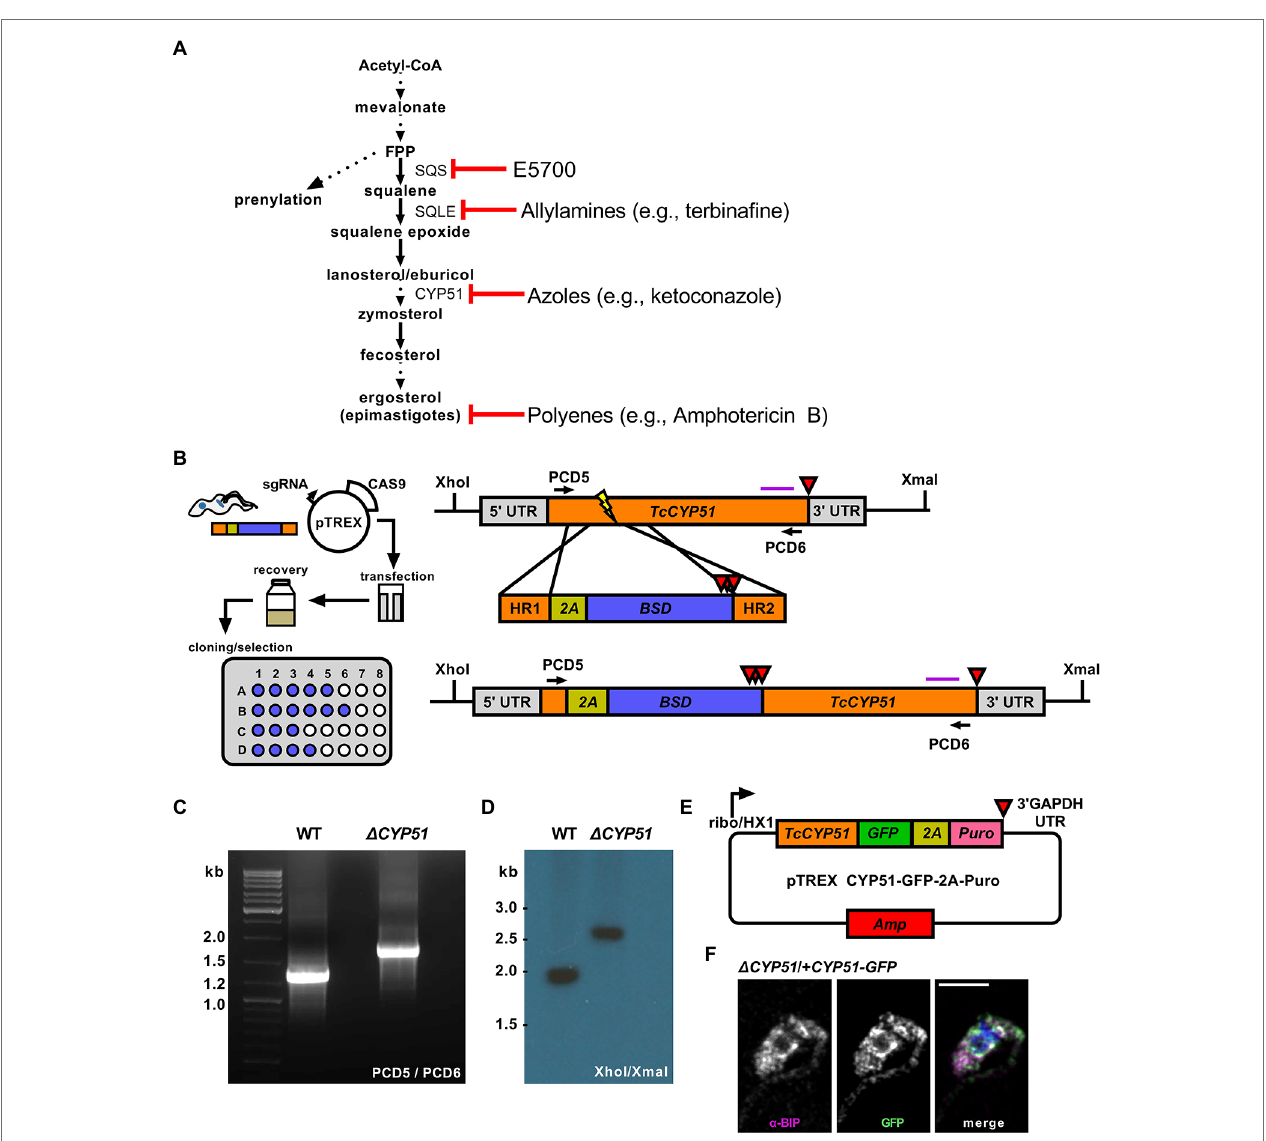
FIGURE 1 | (A) Outline of endogenous sterol synthesis in Trypanosoma cruzi epimastigotes. Dashed arrows indicate the omission of steps for clarity. (B) Outline of epimastigote transfection with Cas9/guide plasmid and linear homology template followed by limiting dilution at 24 h post-transection (left). Schematic of the TcCYP51 locus, homology-directed repair template, and predicted genomic locus following integration. The TcCYP51 coding region and relevant homology arms are shown in orange, skip peptide in yellow, and the blasticidin-S deaminase gene in blue. Red triangles indicate the positions of stop codons. The purple horizontal line corresponds to the predicted binding location for the Southern blot probe; XhoI and XmaI sites in the genome are indicated. (C) Primers flanking TcCYP51 were used to amplify the locus and identify clones with increased band size on an agarose gel. (D) Southern blot following digestion of genomic DNA with XhoI/XmaI and hybridization with a probe binding to the 3 ′ region of TcCYP51 . (E) Construct design for genetic complementation with a C-terminal GFP tagged copy of TcCYP51 and selection with puromycin. (F) Colocalization of GFP tagged CYP51 with the endoplasmic resident chaperone BiP. Mean Pearson’s correlation coefficient (PCC) between the BiP signal and the GFP signal of epimastigotes expressing CYP51::GFP is 0.55 ( n = 707